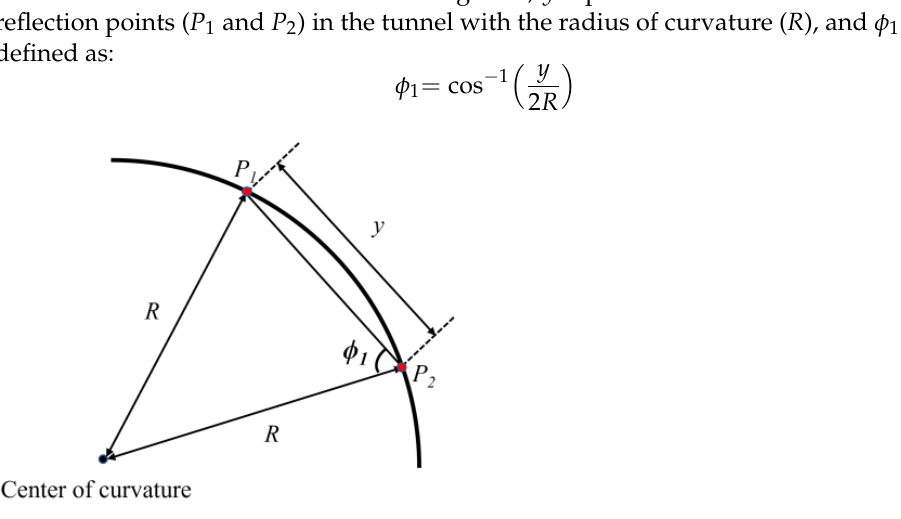
Figure 2. Schematic diagram of reflection in cascaded tunnel.